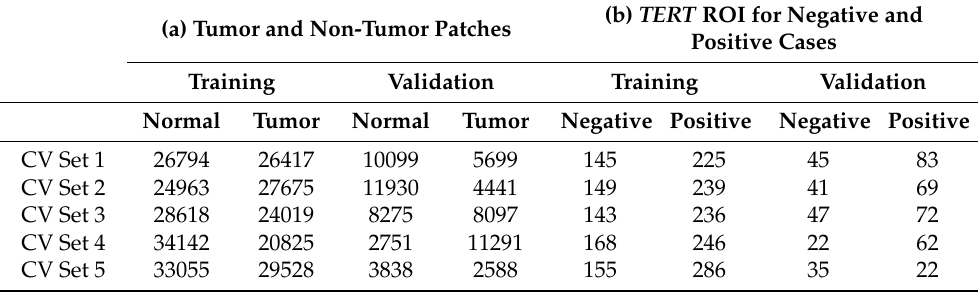
Table 1. Training–validation data split information for tumor classification and TERT prediction: (a) data counts for tumor and non-tumor patches and (b) TERT -negative and TERT -positive ROI boxes in each cross-validation (CV)